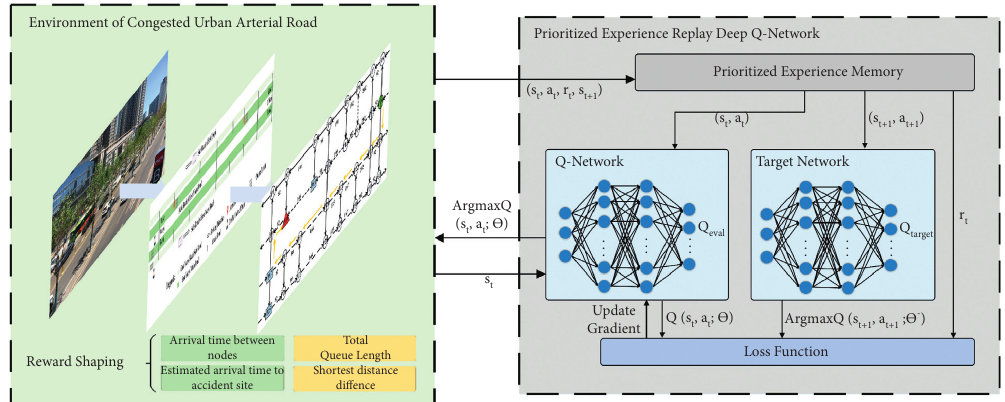
Figure 1: Framework of rescue path planning for emergency vehicles on congested urban arterial road using